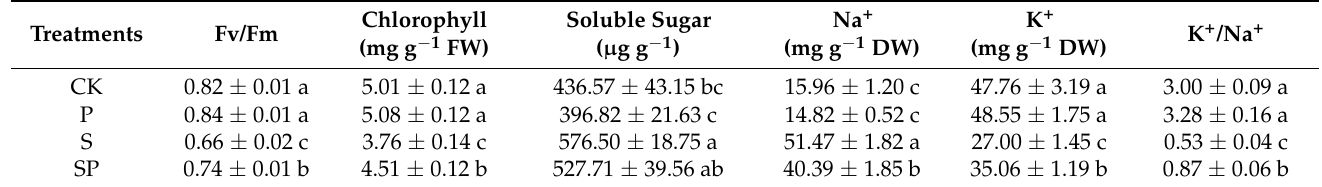
Table 2. Effects of proline (30 mM) treatment on the Fv/Fm, chlorophyll content, soluble sugar content, Na + content, K + content, and K + /Na + ratio of alfalfa under salt